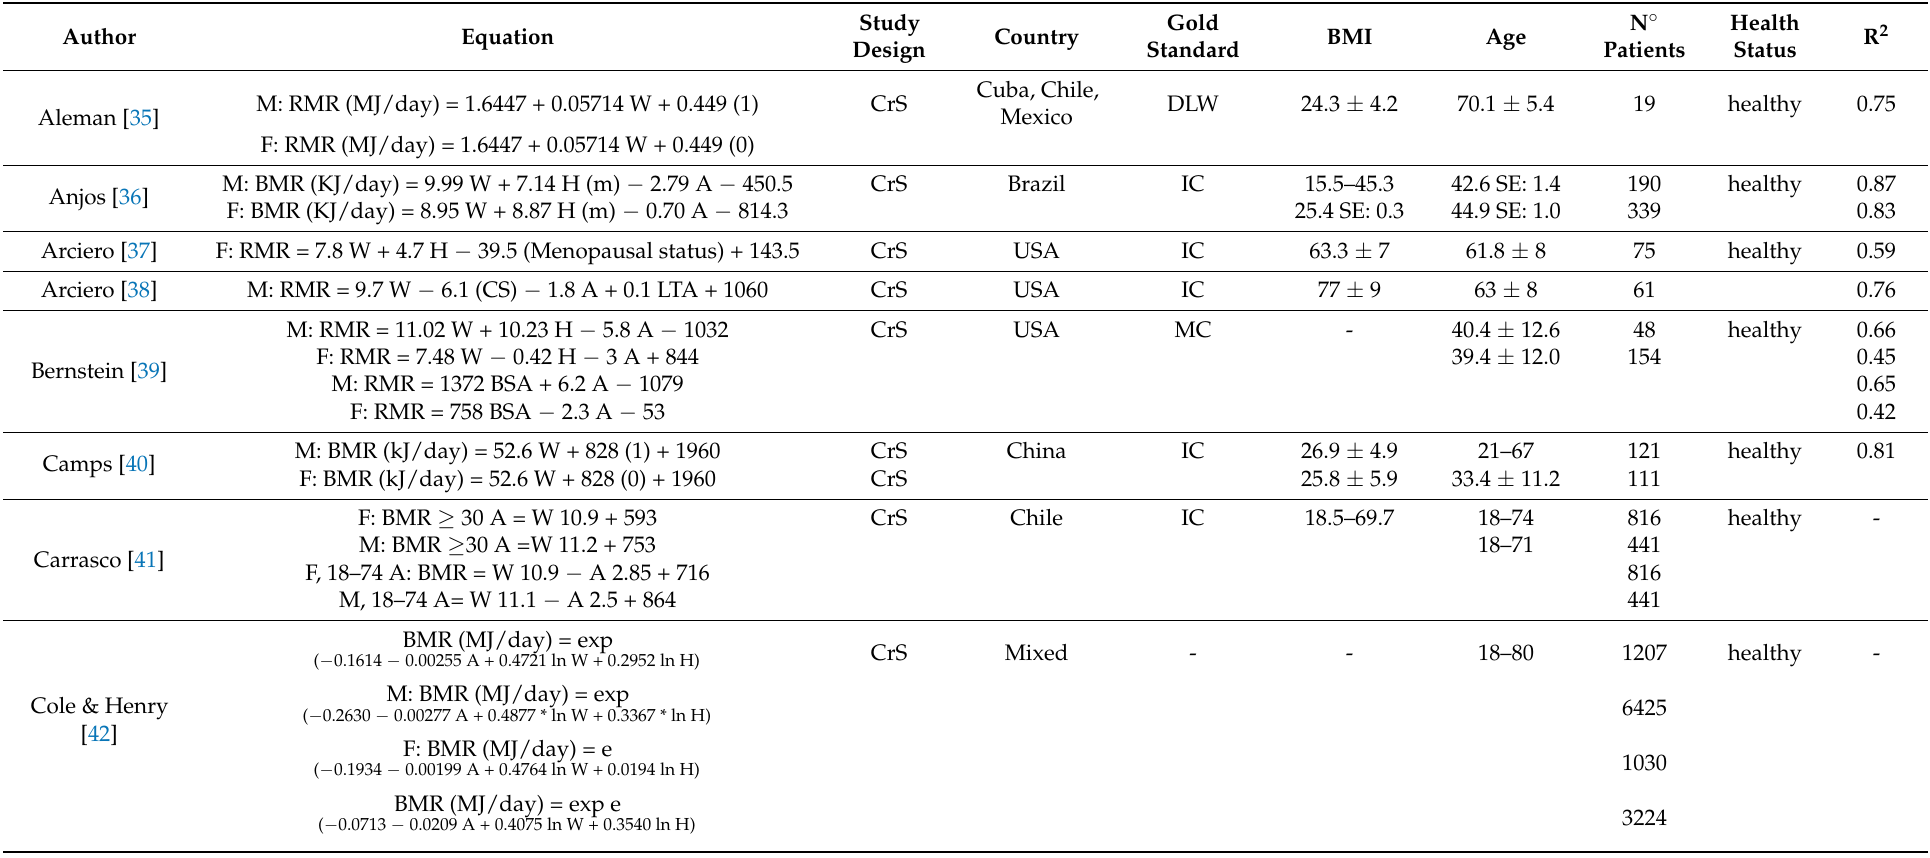
Table 2. Predictive equations retrieved by the systematic review. In the table, equations are shown as in the original article (RMR = Resting Metabolic rate, REE = Resting Energy Expenditure, BMR = Basal Metabolic Rate, BEE = Basal Energy Expenditure, 24EE = 24-h energy expenditure). For each equation is reported the formula and characteristics of the population in which is validated and the coefficient of determination (R2). Equations, when not indicated, are expressed in Kcal/day. Continuous variables are reported with mean and standard